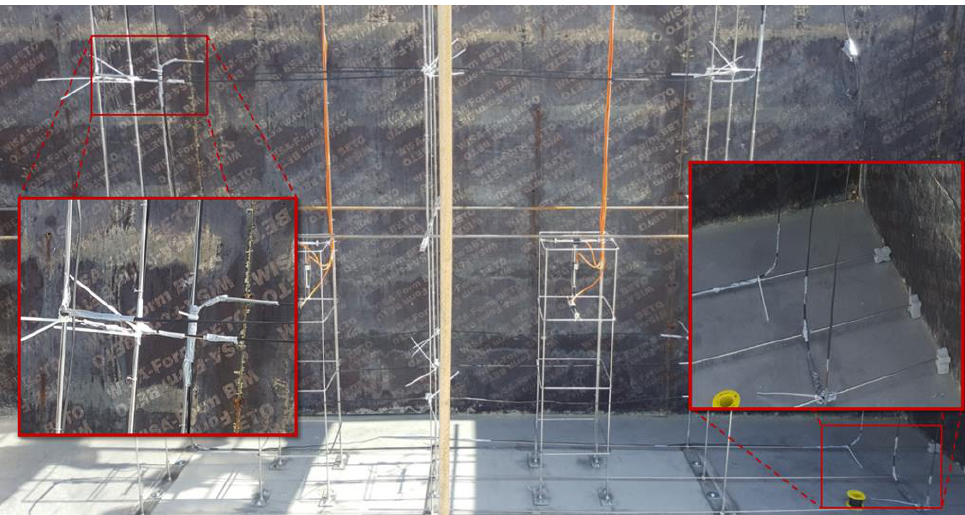
Figure 10. Instrumentation of block IA with embedded DOFS, and details of a metallic guide for curved parts (enclosed picture on the left side) and of the three metallic rods supporting the second vertical plane (enclosed picture on the right side).